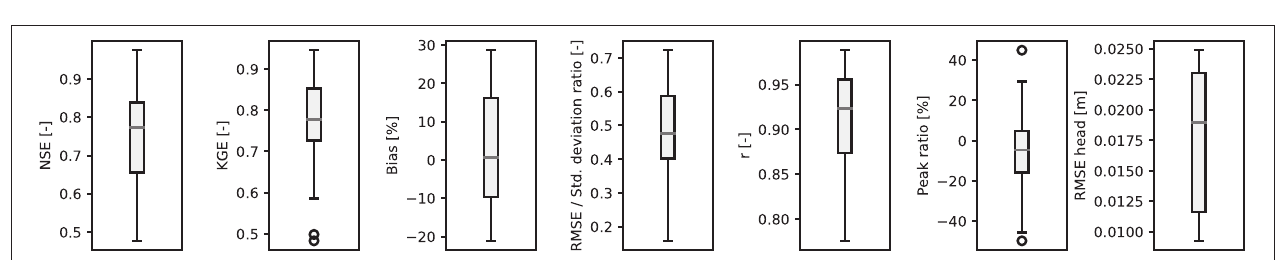
FIGURE 7 | Observed and modeled runoff hydrographs for green roofs with different length (columns) as well as different slopes and rainfall forcing. Runs with asterisk denote experiments considered in the calibration procedure. The remaining experiments are modeled for validation purposes. The left y axis denotes specific runoff per unit area, similar to rainfall, while the right y axis allows for reading the total runoff. Rainfall is shown in form of bars, observed runoff is dotted and lines represent modeled runoff.